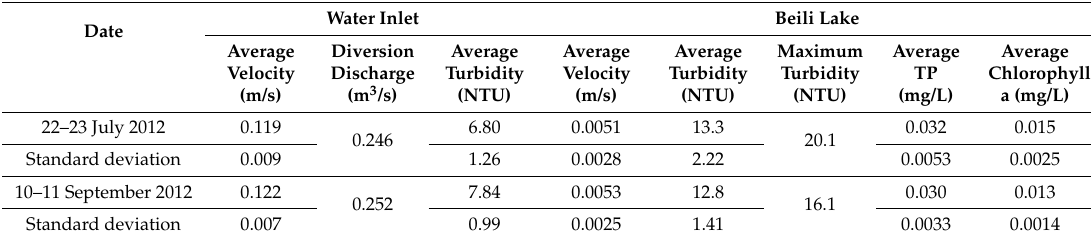
Table 3. Data for the two field observations.